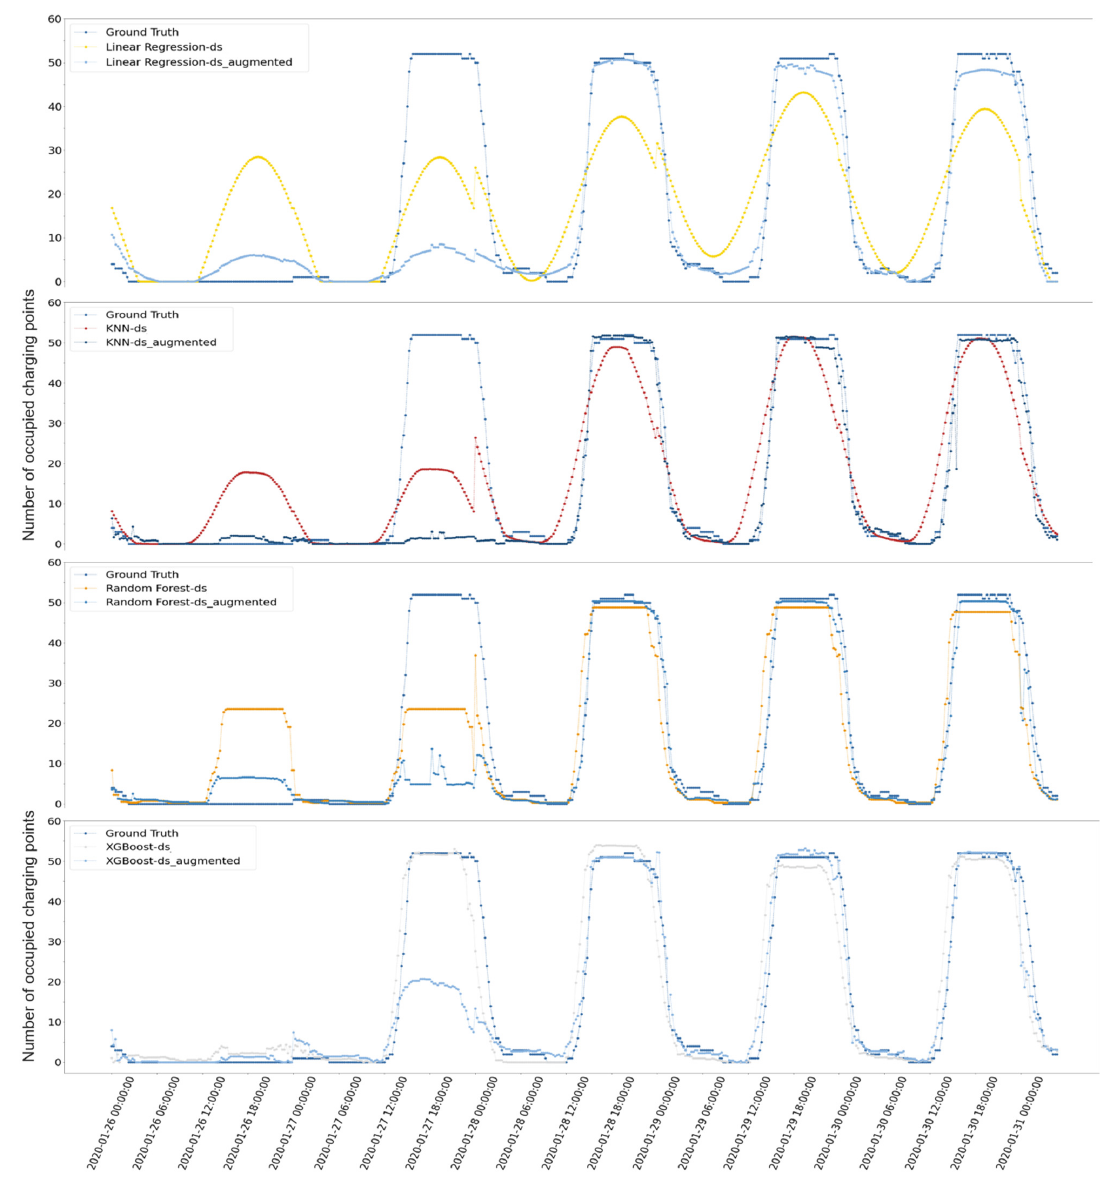
Figure 9. Forecasted occupied number of charging points for last week of January 2020 for JPL for both feature sets.